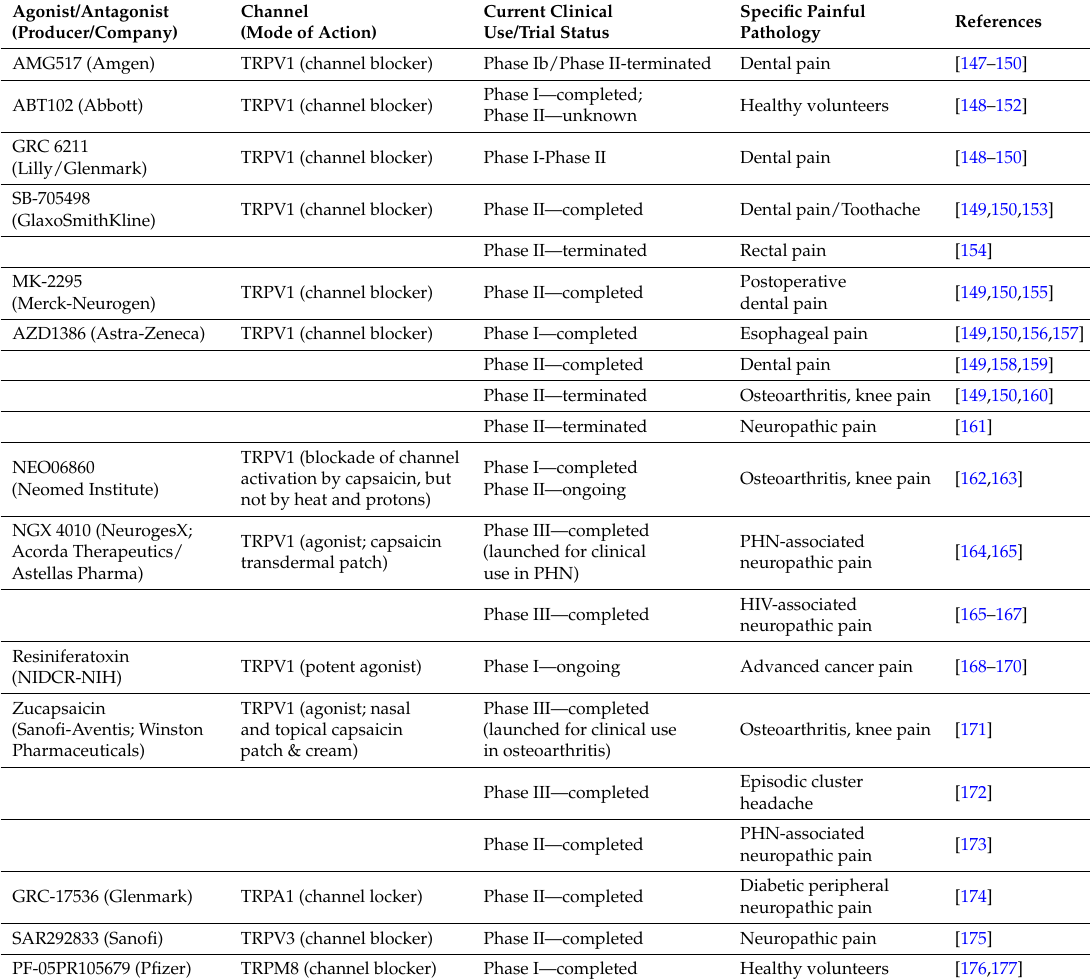
Table 1. Small molecule modulators of TRP channels as drugs in clinical